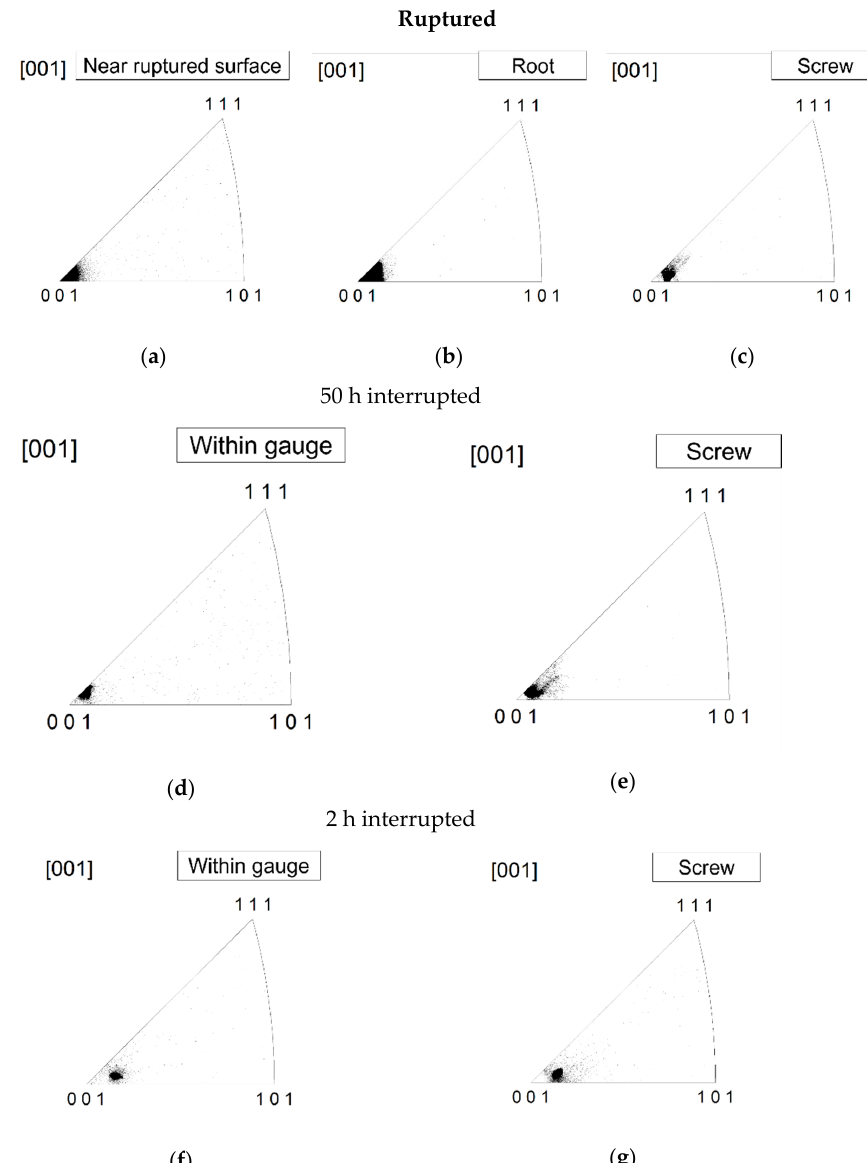
Figure 11. Standard stereographic triangles analyzed using EBSD in specimens perpendicular to the applied stress axis at a condition of 760 °C and 520 MPa. The analyzed area within the gauge